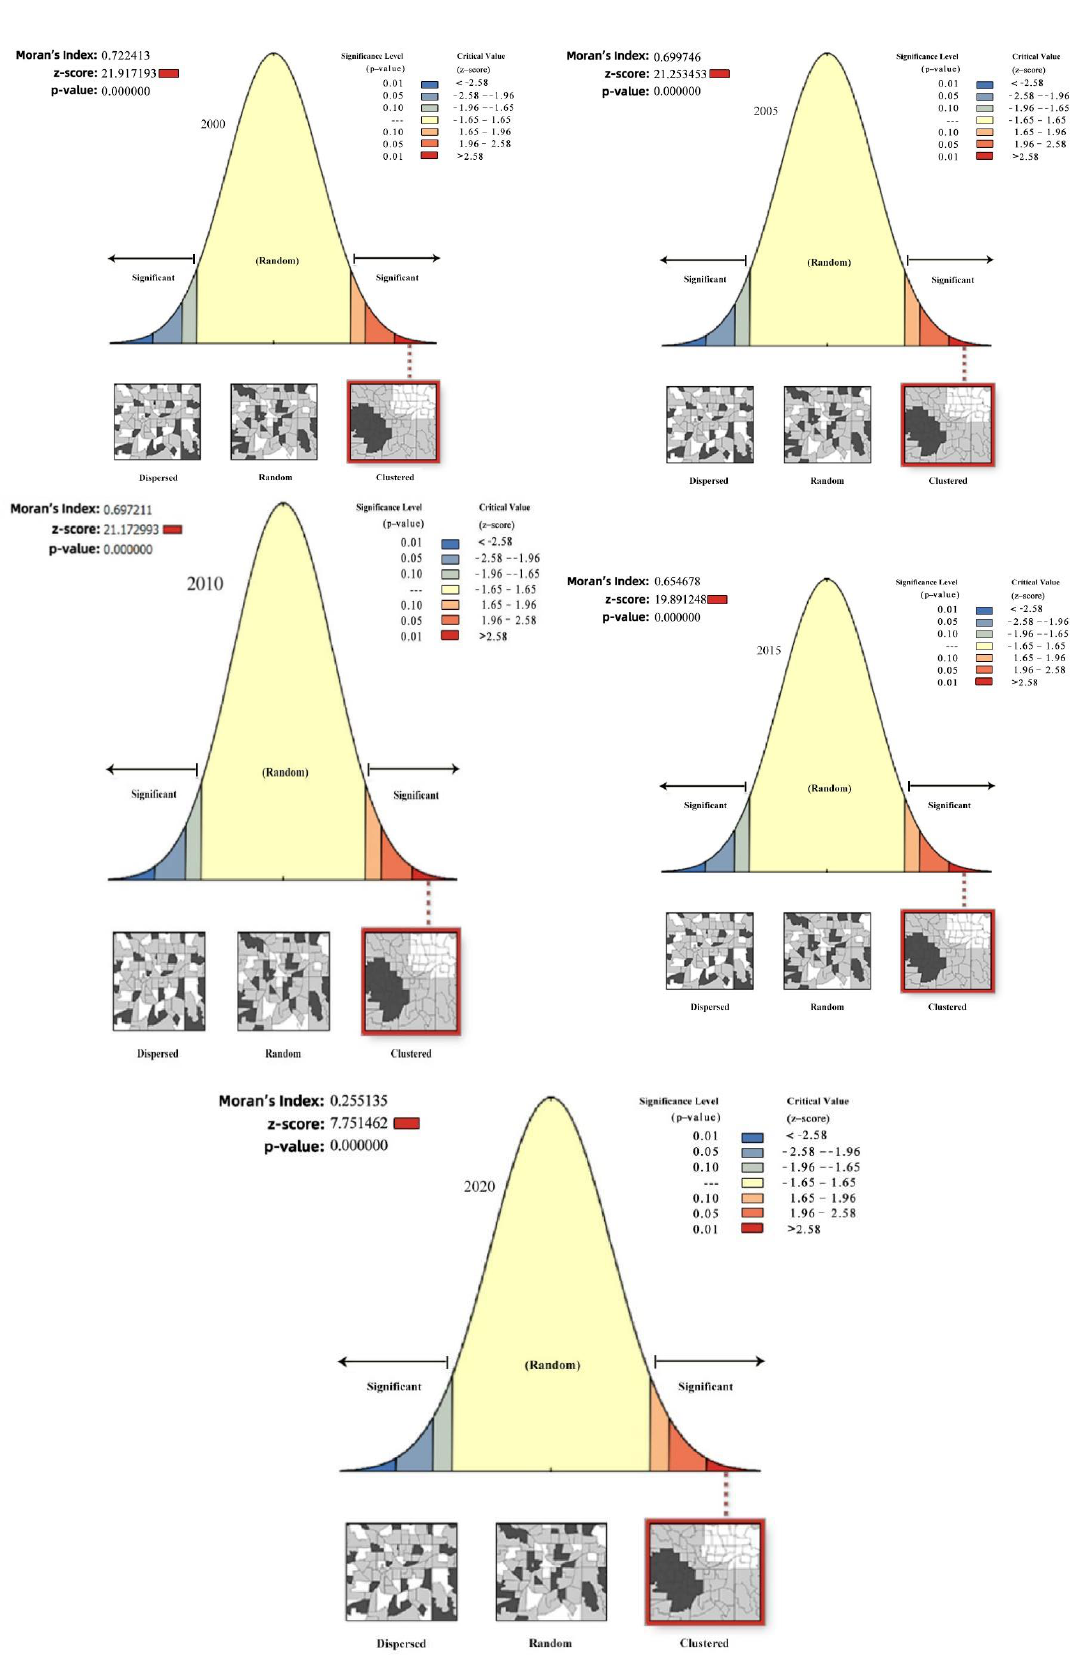
Figure 6. Moran’s map of the ecological environment quality levels in Kuye River Basin in 2000, 2005, 2010, 2015, and 2020 . 2010, 2015, and